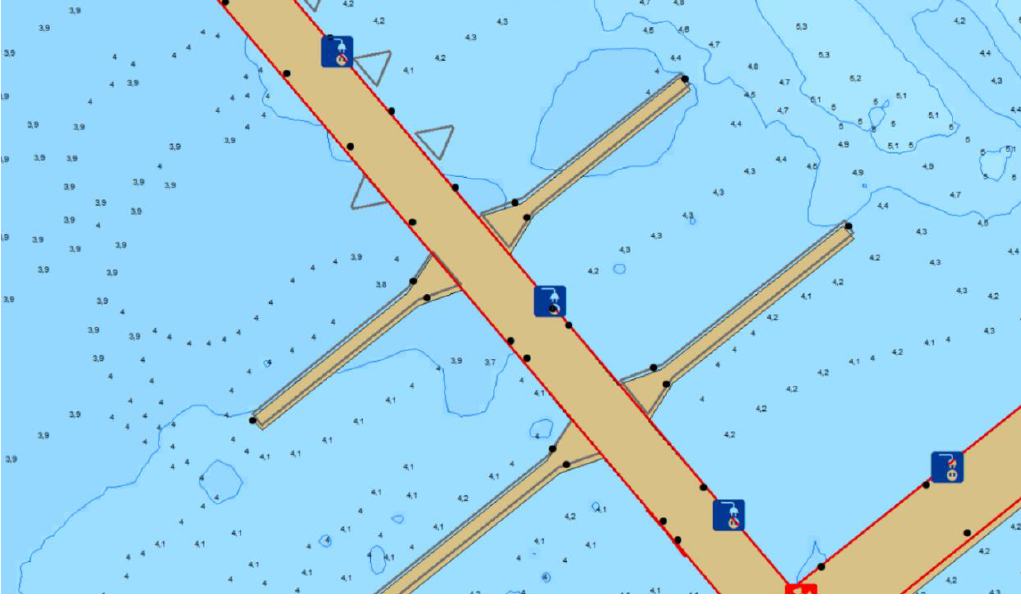
Figure 5. Supplementing the ENC to include missing platforms.